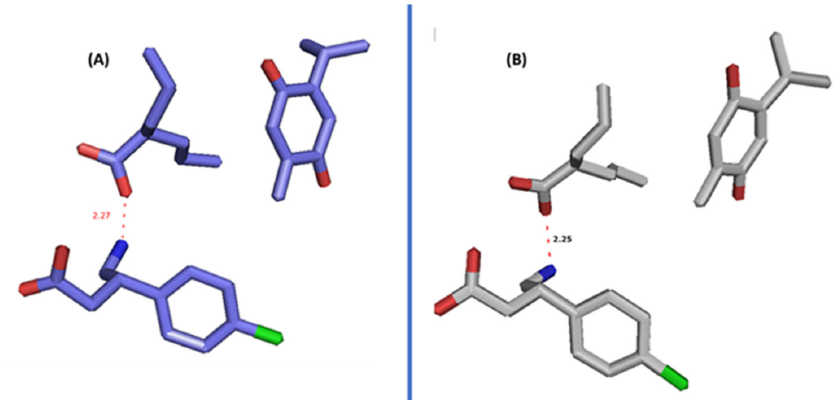
Figure 12. Poses of the three drugs in the supramolecular ternary complex, ( A ) alone and ( B ) after docking in dynamics in Akt enzyme ( B ).